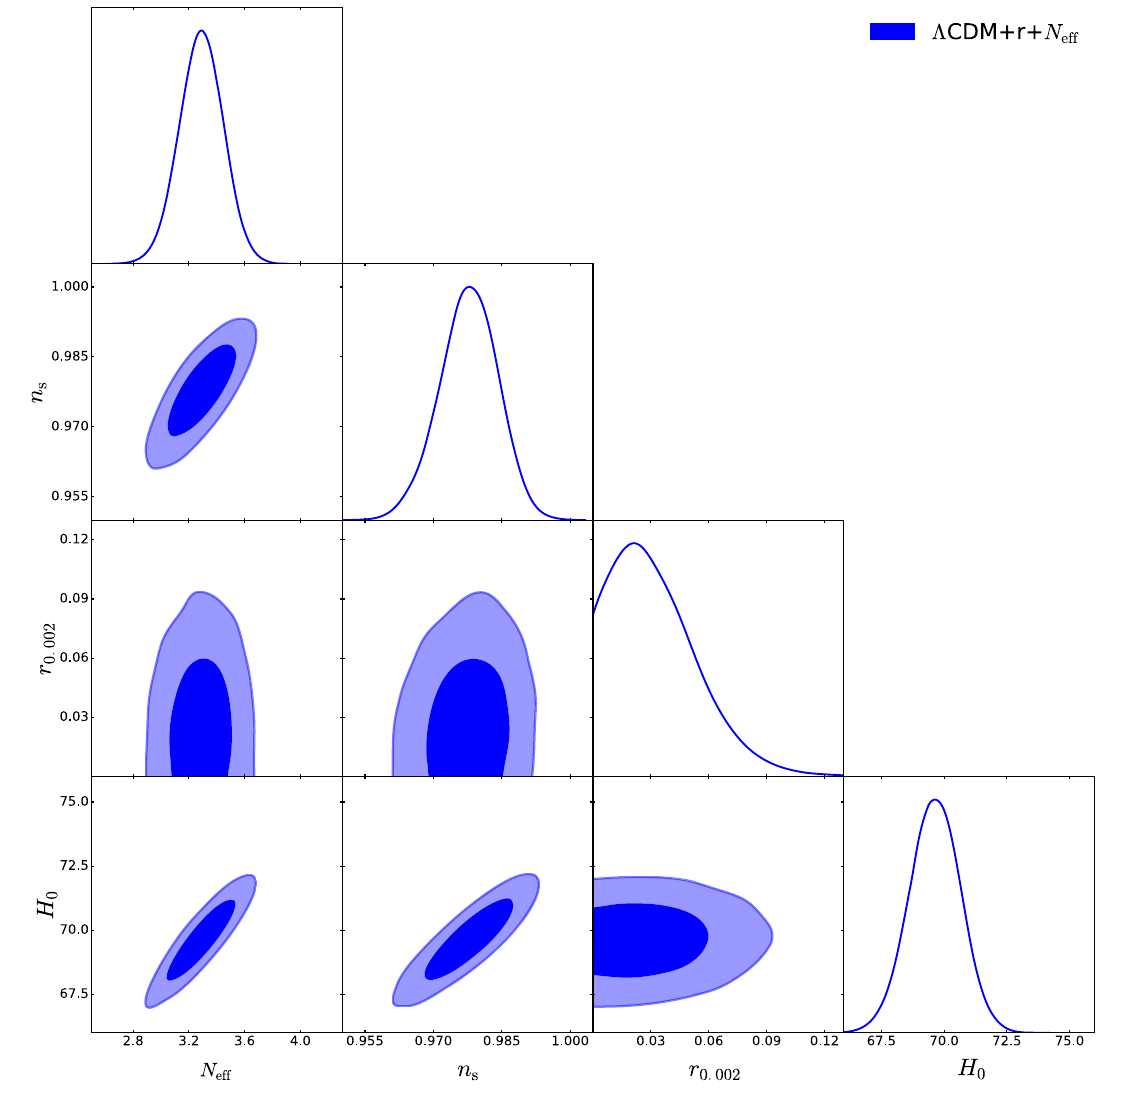
Fig. 3 One-dimensional marginalized distributions and two-dimensional contours (1 σ and 2 σ ) for parameters N eff , n s , r 0 . 002 , and H 0 in the (cid:2) CDM + r + N + BK + BAO + H eff model using the Planck 0